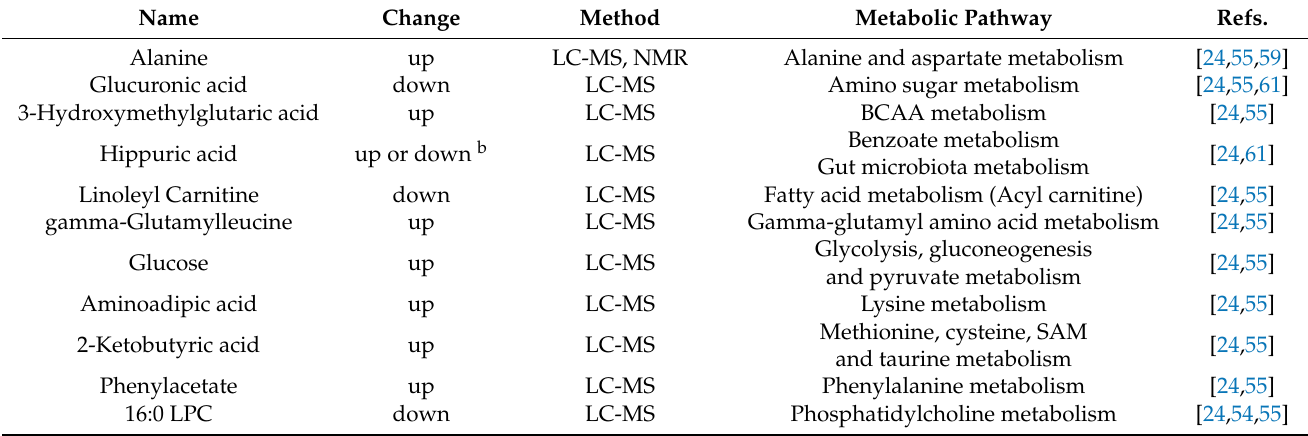
Table 1. Summary of plasma metabolite alteration following metformin treatment in non-diabetic participants ( p ≤ 0.05) a .